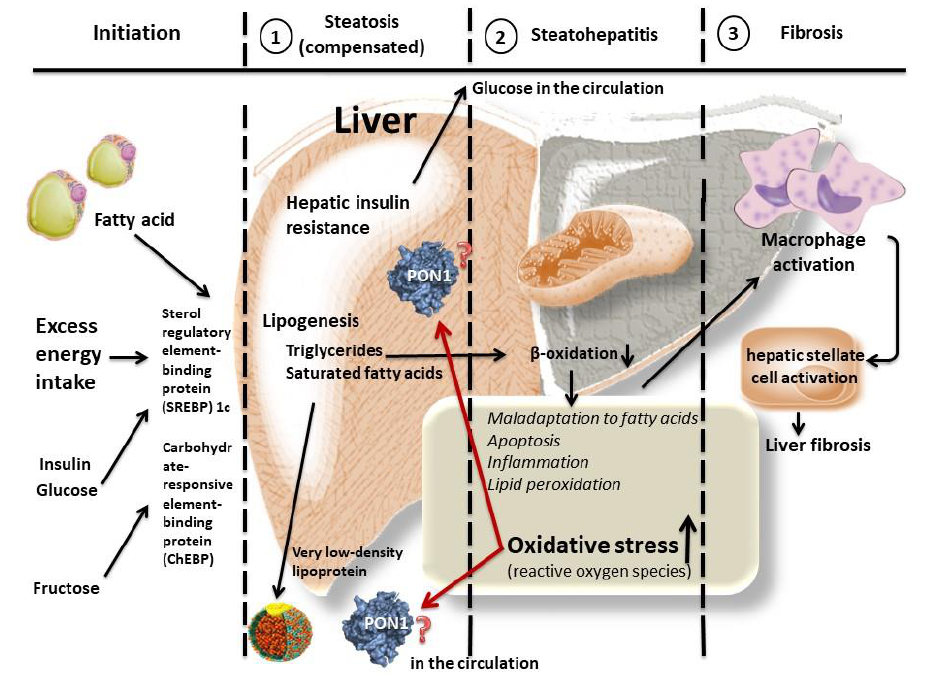
Figure 1. Speculative association of paraoxonase 1 (PON1) with nonalcoholic fatty liver disease (NAFLD). There are different grades of NAFLD, including steatohepatitis. Various molecules are associated with the development of the disease, and oxidative stress is a key to its progression. Antioxidants have a defensive role against the excess oxidative stress. Paraoxonase 1 (PON1), an antioxidant molecule, is produced in the liver and is secreted into the circulation; therefore, PON1 may play a relevant role in the pathophysiology of NAFLD. Circulating PON1 levels could serve as surrogate biomarkers of the underlying cause of the disease. Paraoxonase 1 (PON1: aryldialkylphosphatase (EC3.1.8.1)) is known as an esterase